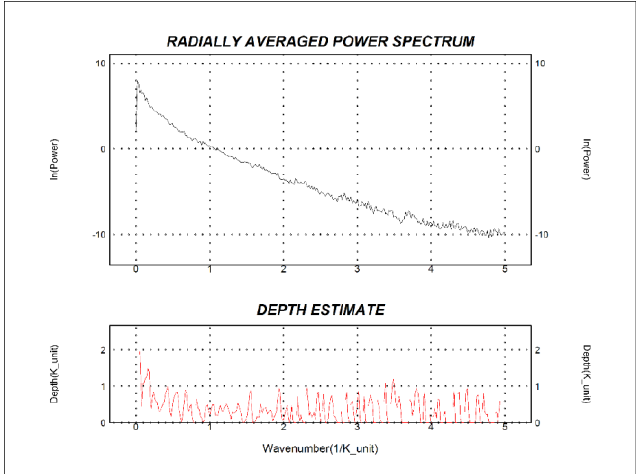
Figure 10: Colour Shaded Pseudo-Gravity Image